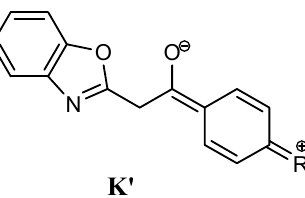
at 303 K), [ O ] (%) = 100 − [ K ] 3